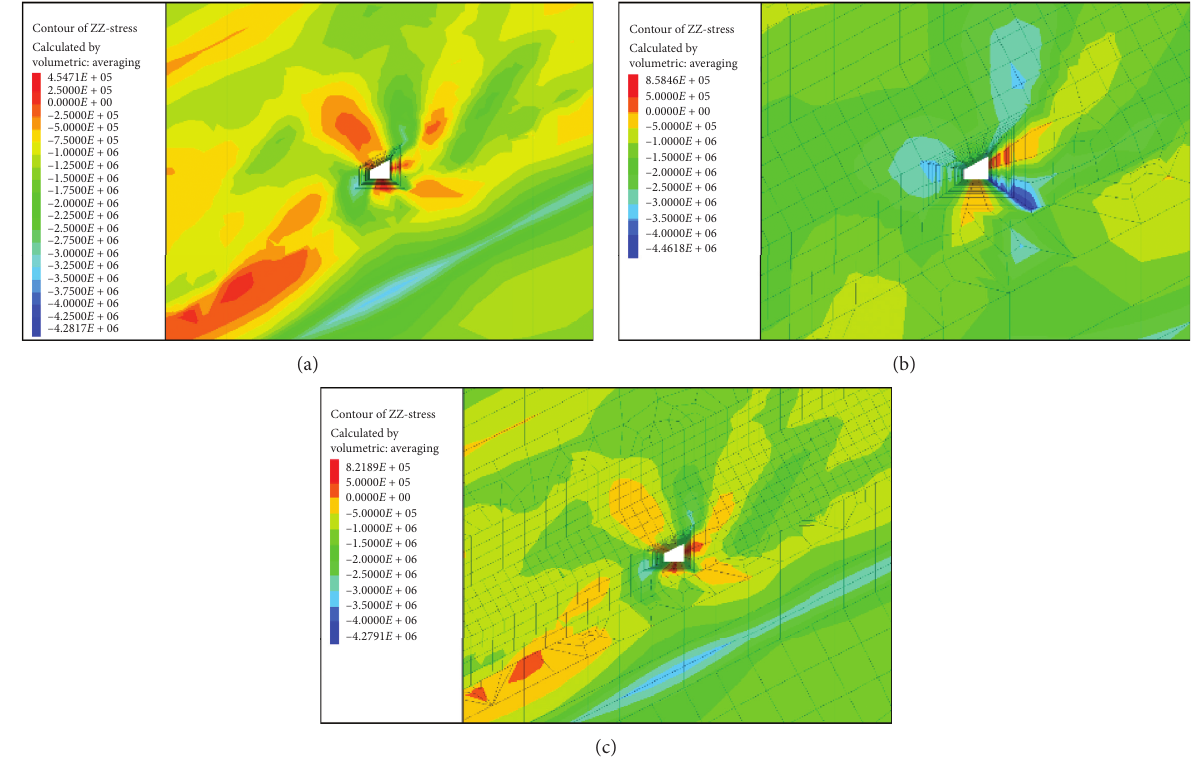
Figure 6: Stress distribution. (a) Unsupported. (b) Bolt support. (c) Bolt-anchor cable